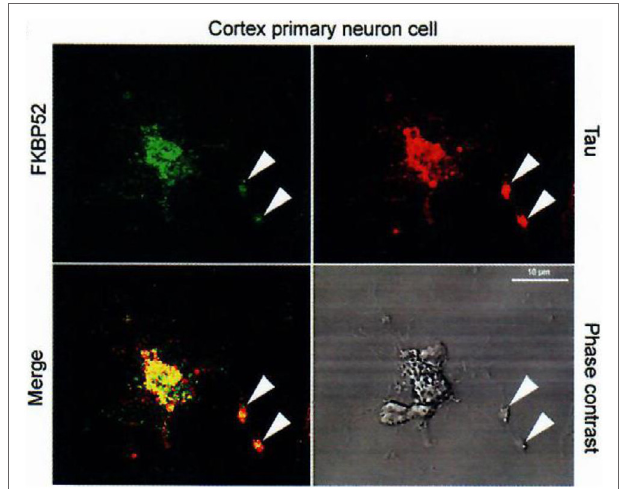
FIGURE 5 | Colocalization of FKBP52 and Tau in primary cortical neurons and PC12 cells. Immunofluorescence staining of primary cortical neurons and PC12 cells treated with 50 nM NGF for 5 days. Double staining for Tau and FKBP52 was performed after cytosol extraction to reveal cytoskeletal association. Arrows indicate preferential colocalization of both proteins in the distal part of the nerve cell axon and at the extremity of PC12 cell neurites. Confocal images of primary cortical neurons. Analysis of 0.5-µm slices confirms the preferential colocalization in the distal part of the axon (arrowheads). Data from Chambraud et al.